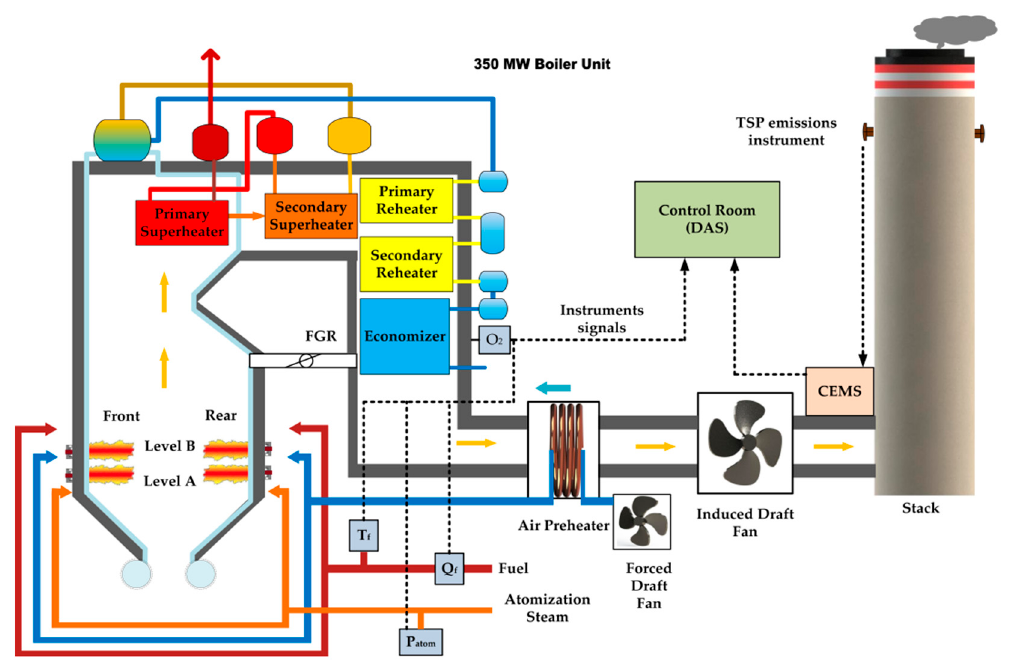
Figure 2. Boiler unit configuration. TSP: total suspended particles, CEMS: continuous emissions monitoring systems, T f : fuel temperature, Q f : fuel mass flow, P atom : atomization pressure, O 2 : oxygen excess, FGR: flue gas recirculation, DAS: data acquisition system.